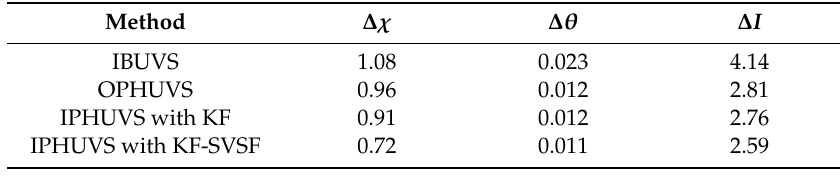
Table 5. Steady-state error of different strategies in the static positioning experiment. χΔ is in millimeters, θΔ is in degrees and I Δ is in pixels .